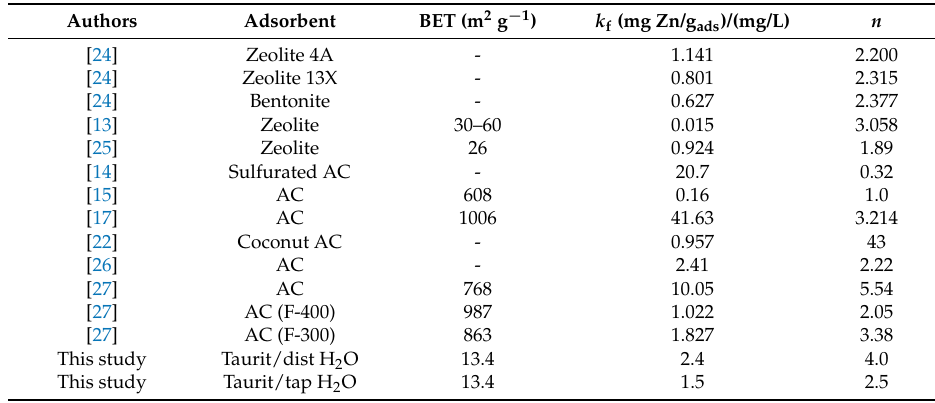
Table 3. Freundlich isotherm parameters for zinc